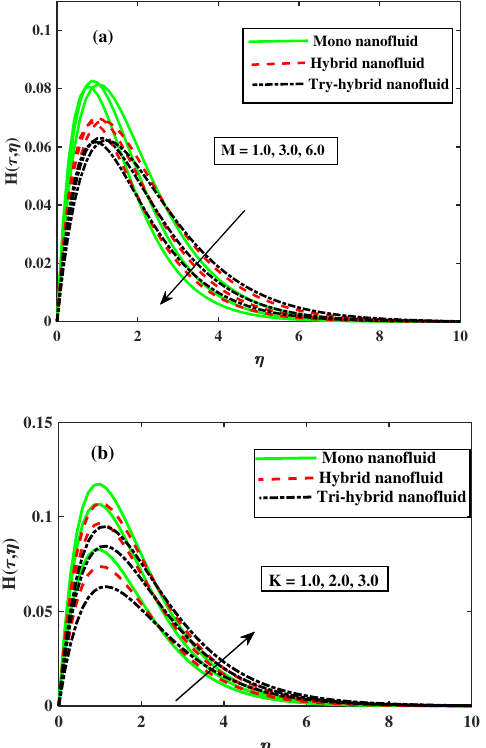
Figure 3. ( a ) Fluctuation of M on H ( τ , η ) ; ( b ) Fluctuation of K on H ( τ , η )